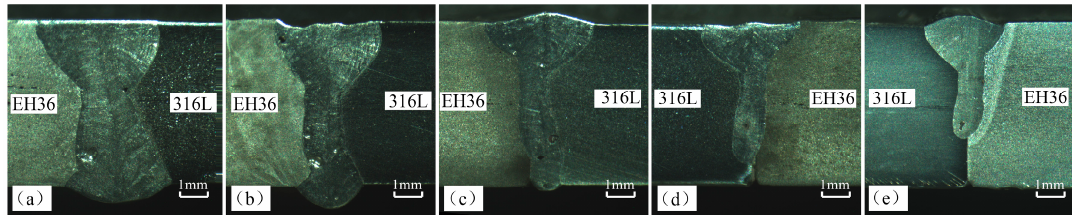
Figure 3. Influence of welding speed on the cross section: ( a ) 0.4 m/min; ( b ) 0.6 m/min; ( c ) 0.8 m/min; ( d ) 1.0 m/min; and ( e ) 1.2 m/min.